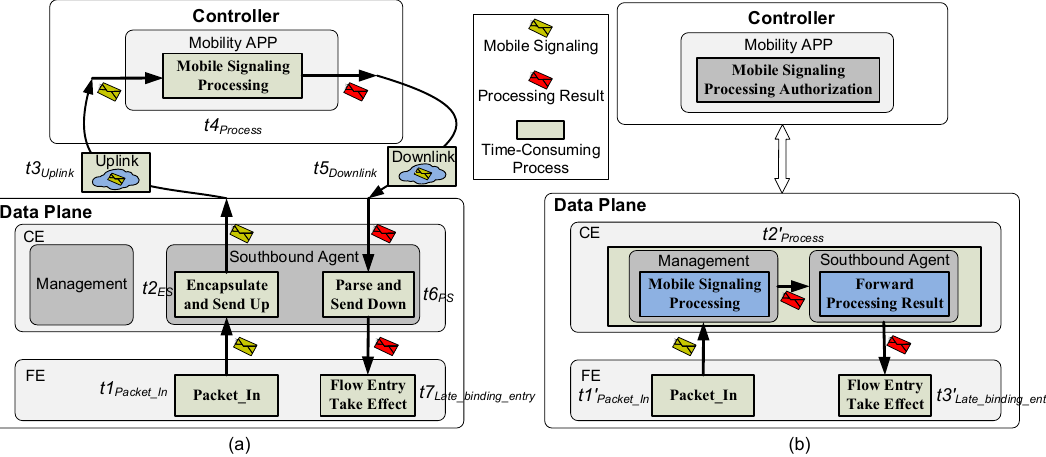
Figure 3. ( a ) Latency of the traditional programmable data plane for processing mobile signaling. ( b ) Latency of the enhanced programmable data plane for processing mobile signaling. Table 1. Description of the symbols in Figure 3. Symbol Description